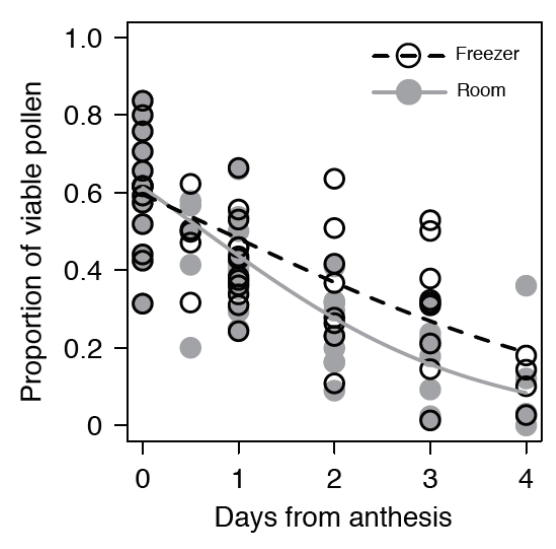
Figure 5. Pollen longevity of Salix caprea under two temperature conditions, showing the relationships between the proportion of viable pollen and days elapsed since pollen release from anthers. Because the model fitted to the pooled data suggested a significant difference between the two temperature conditions ( χ 2 = 39.1, P < 0.0001, type-II Wald chi-square test) with a significant interaction between days and temperature ( χ 2 = 79.1, P < 0.0001, type-II Wald chi-square test), the regression curves are drawn separately for the two temperature conditions based on the estimated fixed effects. The number of seeds was adjusted for the estimated random effect (plant) prior to data plotting. all three pollination modes are used simultaneously to ensure